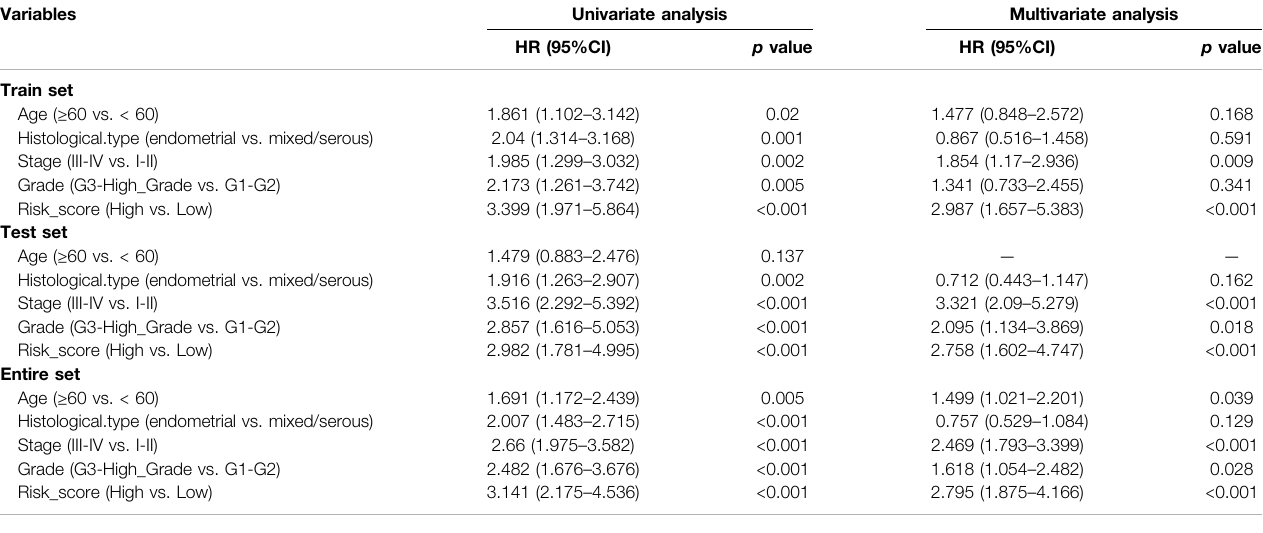
TABLE 2 | Univariate and multivariate investigation of clinic pathologic aspects for its comprehensive survival in UCEC patients.